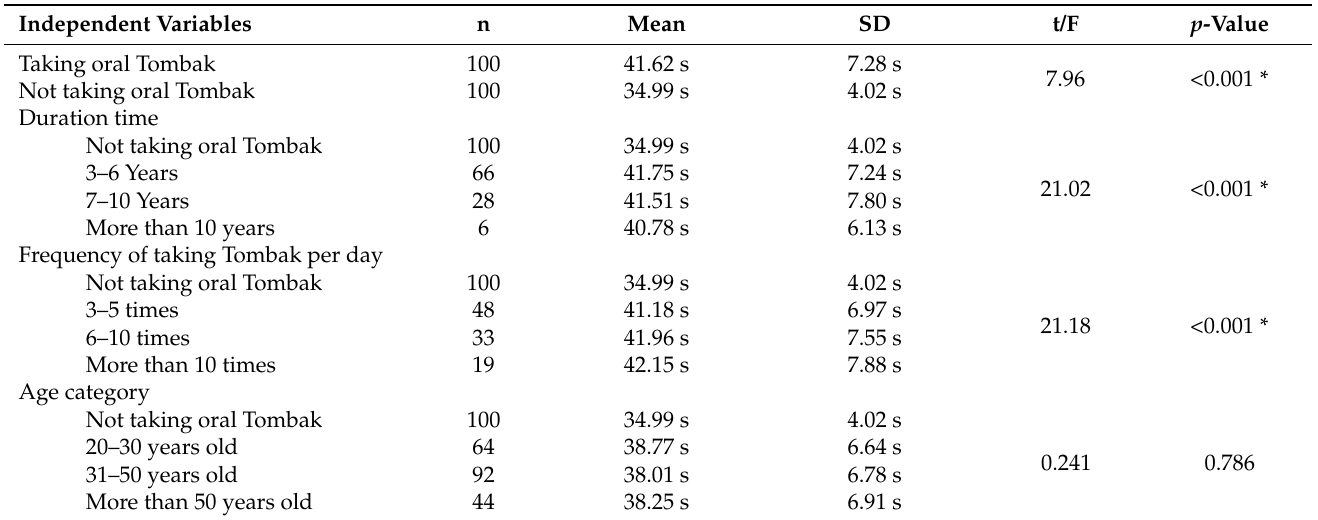
Table 3. The effects of taking oral Tombak on activated partial thromboplastin time (APTT)values among the study population.